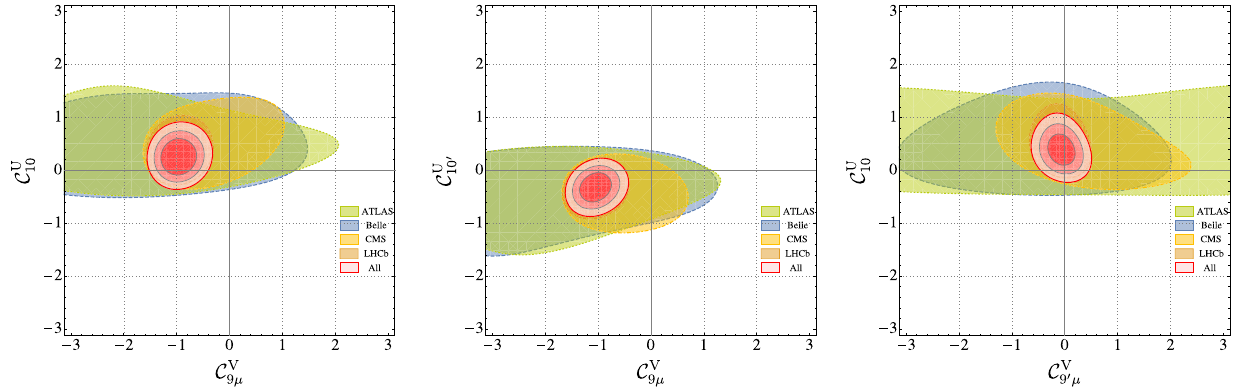
Fig. 4 Updated plots of Ref. [2] corresponding to the new scenarios 10, 11,